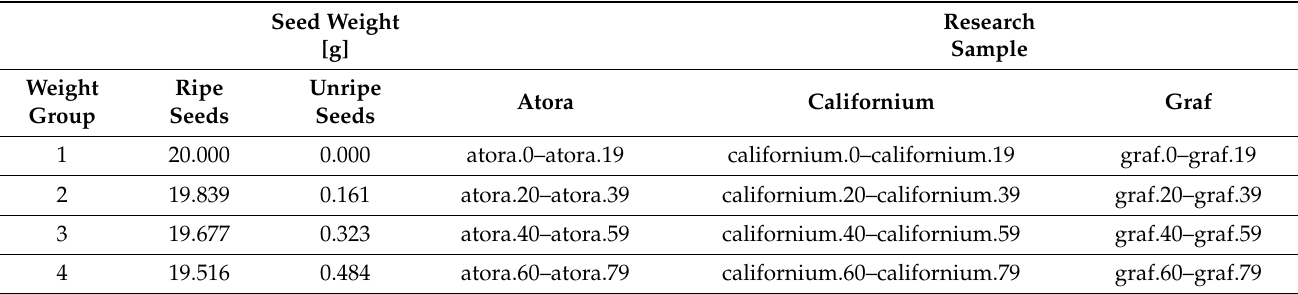
Table 1. Weight group of the imaged three winter rape seed samples (rape and unripe) with the respective